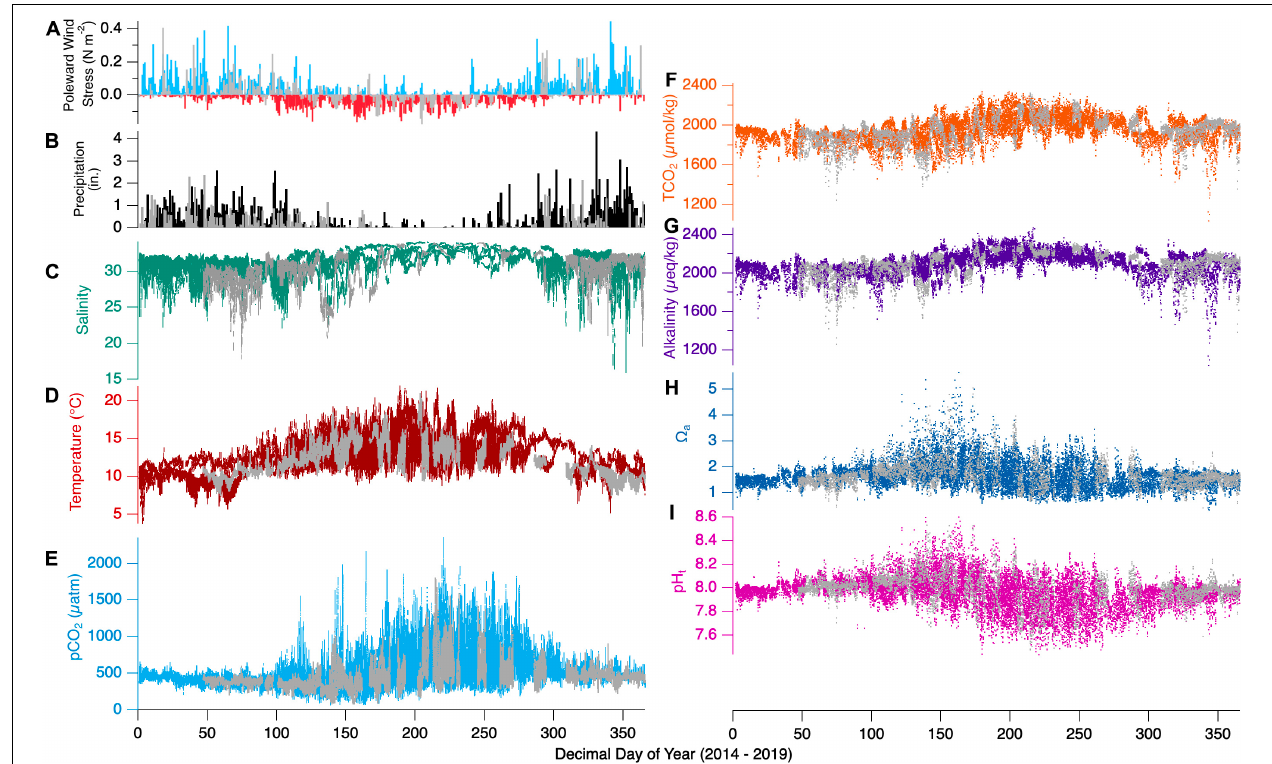
FIGURE 5 | Composite observations for Netarts Bay 2014–2019. (A) Poleward wind stress, (B) daily precipitation in inches, (C) salinity (teal line), (D) temperature (red line), (E) pCO 2 (cyan line), (F) TCO 2 (orange dots), (G) calculated alkalinity (purple dots), (H) aragonite saturation state ( (cid:127) a ,blue dots), and (I) pH (pink dots). Dark gray shading of each parameter represents the 2017 data set. Wind stress data available at: http://damp.coas.oregonstate.edu/windstress/Precipitation data courtesy of